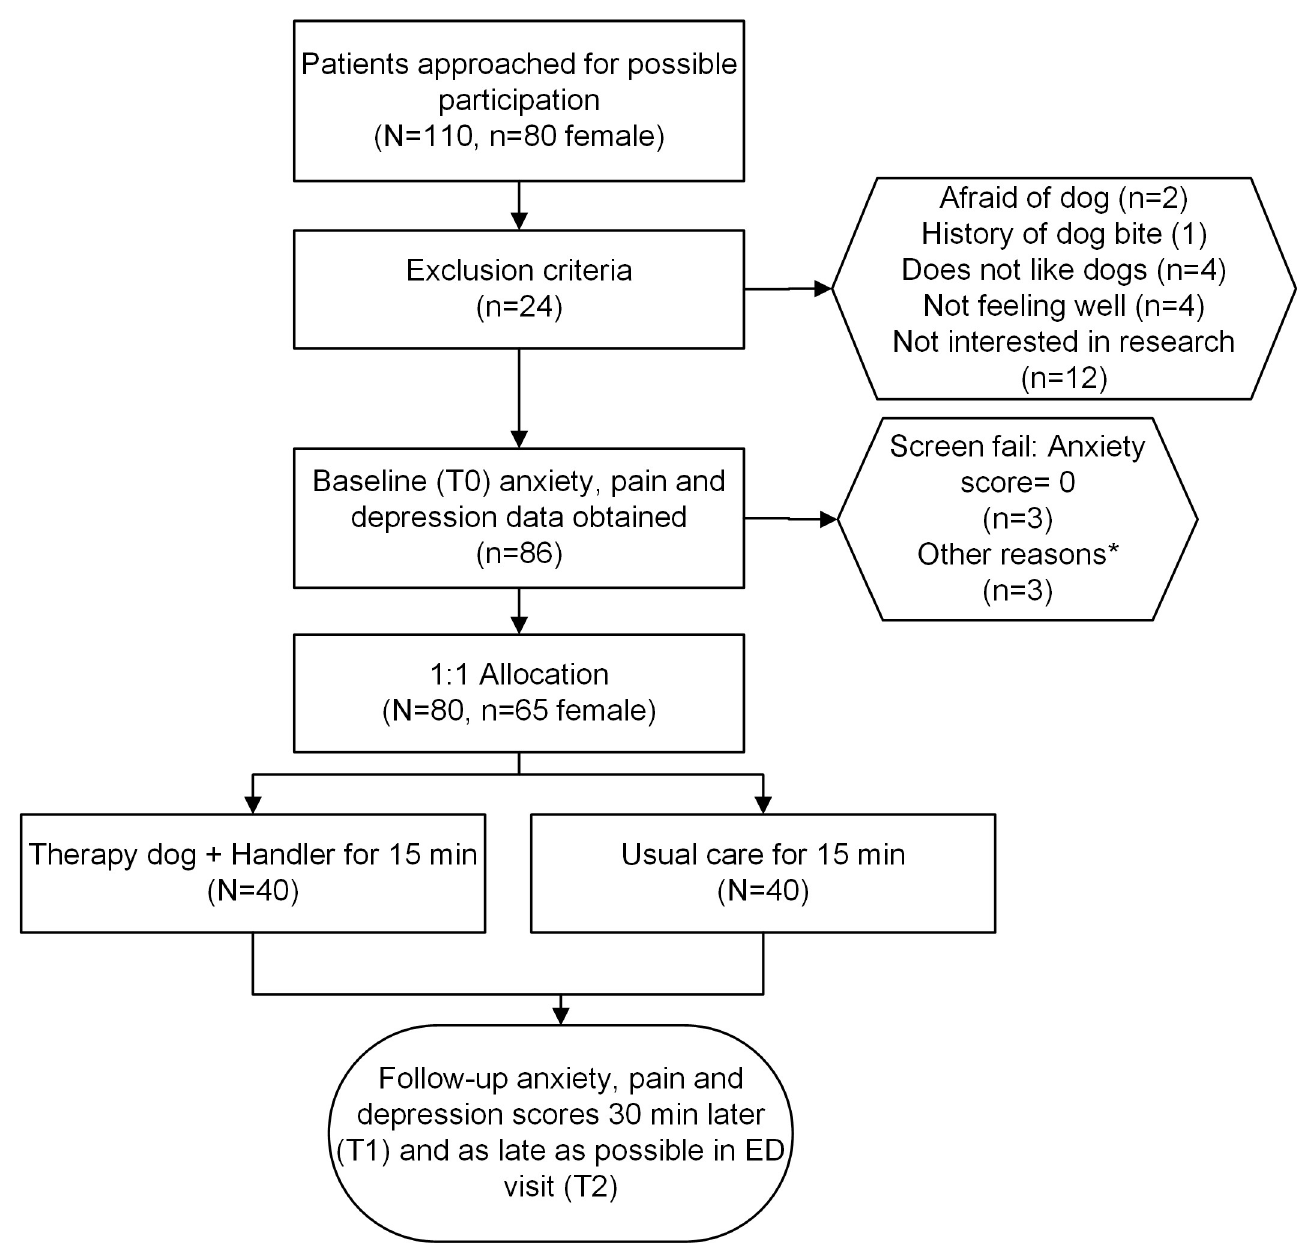
Fig 1. Consort flow diagram. Flow diagram of patients approached for participation � Reasons for voluntary withdrawal: 1. Patient was worried that police would come in with the dog; 2. Likes dogs, but not for her. Thinks therapy dogs would help people though; 3.Goes to therapy every other week and there is a dog there, but didn’t want to see one